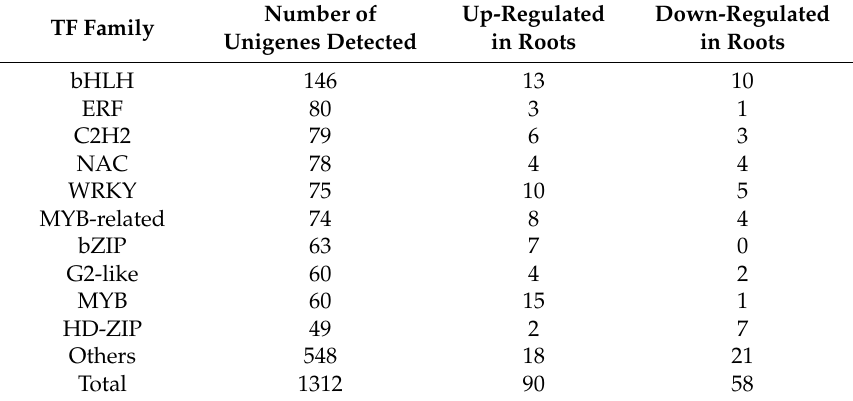
Table 5. Summary of transcription factor (TF) unigenes in C. arachnoidea